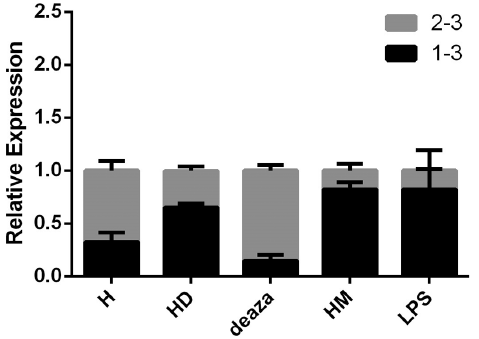
Figure 3 - Average methylation levels of MEFV second exon in different cell culture models. H: untreated HL-60 cells; HD: HL-60 cells trans- formed to neutrophil-like cells via DMSO; deaza: demethylated HL-60 cells using deazacytidine; HM: methylated HL-60 cells with methanol; LPS:HL-60cellsactivatedthroughPMA&LPS.Thesemethylationcom- parisons were non-significant, with a trend in H vs. HD (p = 0.4) and H vs. LPS(p=0.053)(p<0.05wasconsideredstatisticallysignificant,N=3for each cell